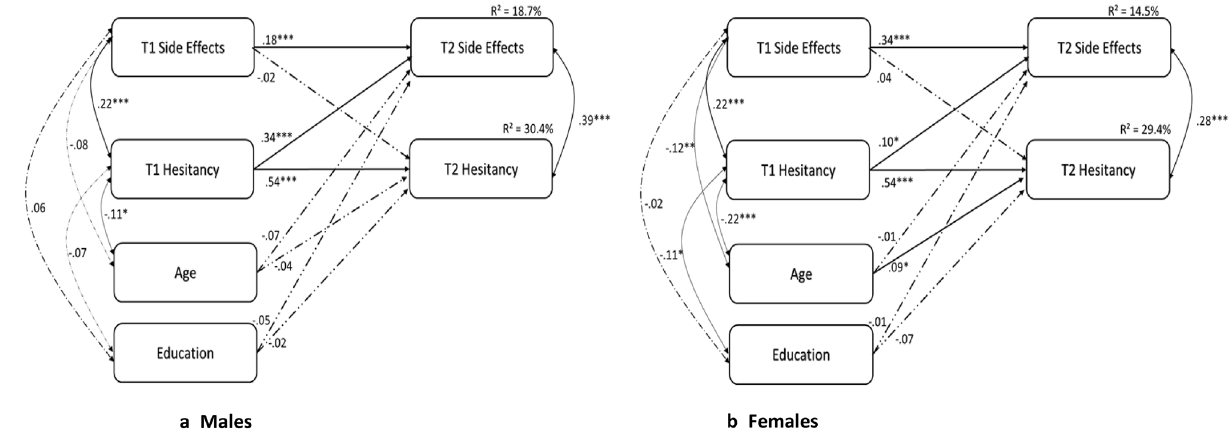
Figure 2. The Multi-Group Cross-lagged associations between vaccine hesitancy and vaccine side-effects for Males ( a ) and Females ( b ). Notes N = 756, * p < 0.05, * * p < 0.01, * * * p <